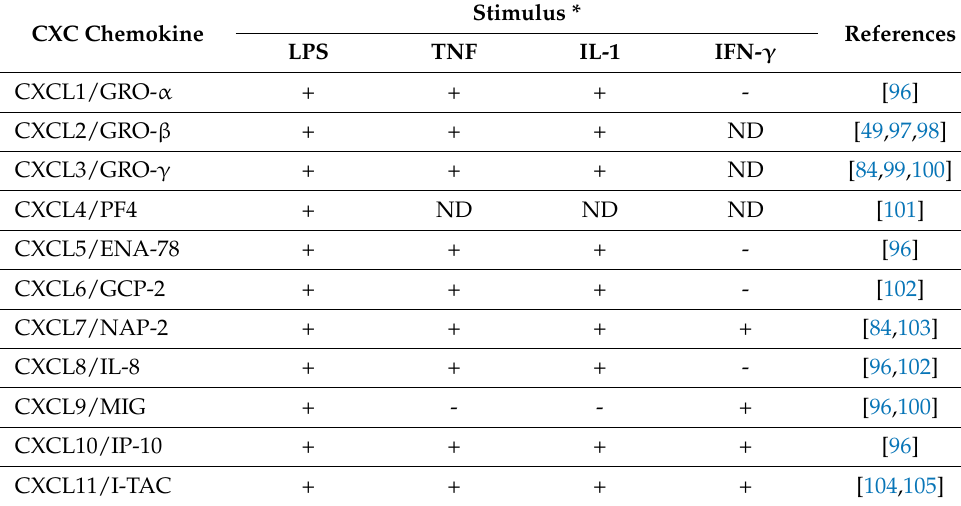
Table 3. Specificity of the stimulus for CXC chemokine expression and